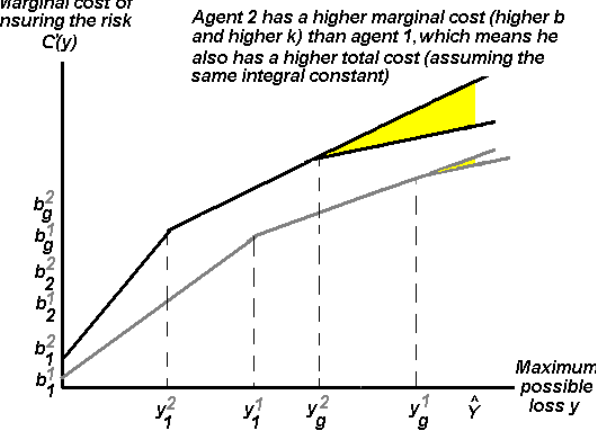
Fig. 5. Gain from government